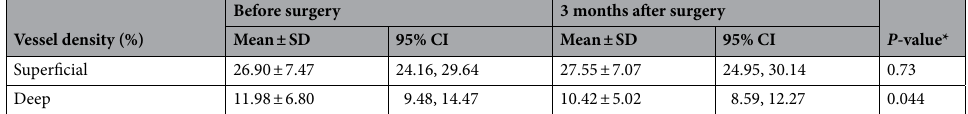
Table 2. Comparison of deep vessel densities before and after minimally invasive glaucoma surgery (N = 31). CI, confidence interval; SD, standard deviation. *Wilcoxon signed-rank test.